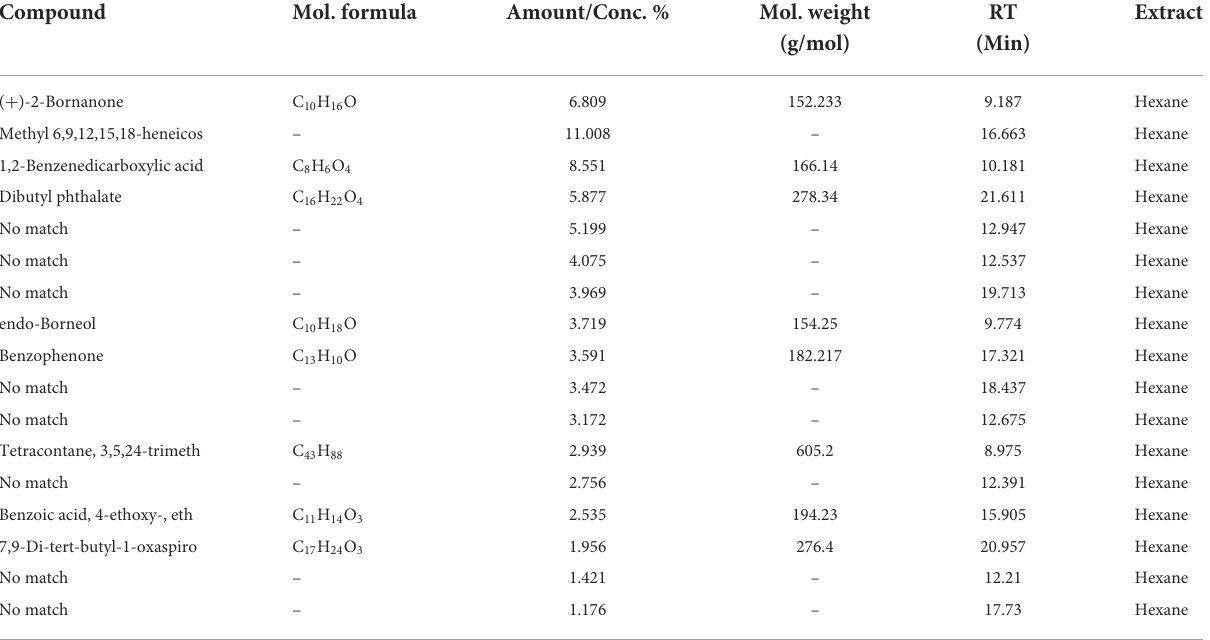
TABLE 6 GC/MS analysis of a hexane-based extract of N. cataria using NIST 17 Library showed (9 identified phytochemicals + 8 unmatched) chemicals, arranged according to concentration present. Compound Mol. formula Amount/Conc. % Mol. weight